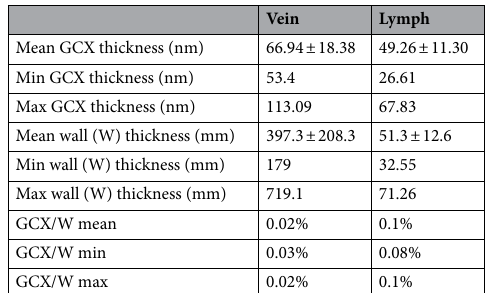
Table 1. Mean, minimum and maximum values of vein and lymphatic wall (W) and glycocalyx-like structure (GCX) thickness. GCX/W indicates the glycocalyx-like/wall thickness